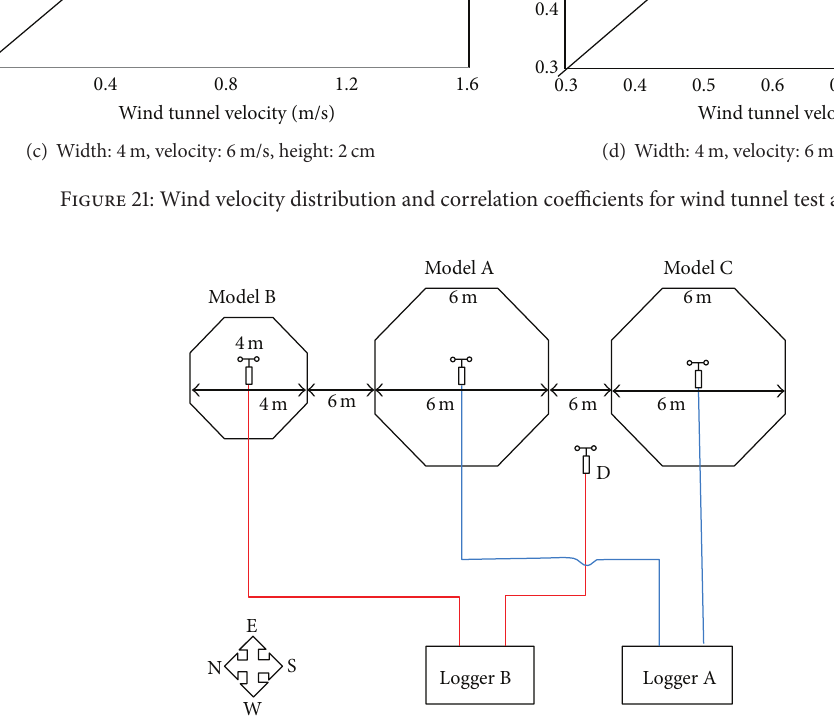
Figure 22: Arrangement plan and measurement process of